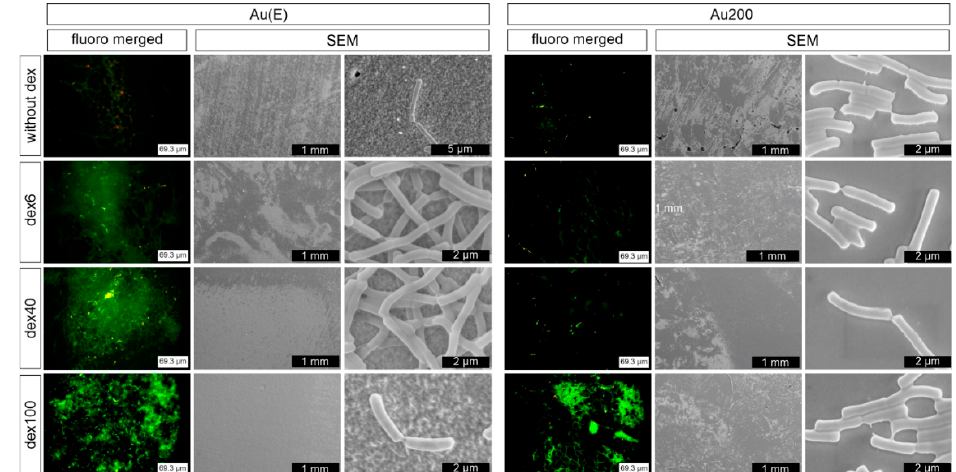
Figure 8. Fluorescence and SEM microphotographs of Lactobacillus rhamnosus GG after 24 h of incubation at Au(E) and Au200 substrates with and without polymer modifications.